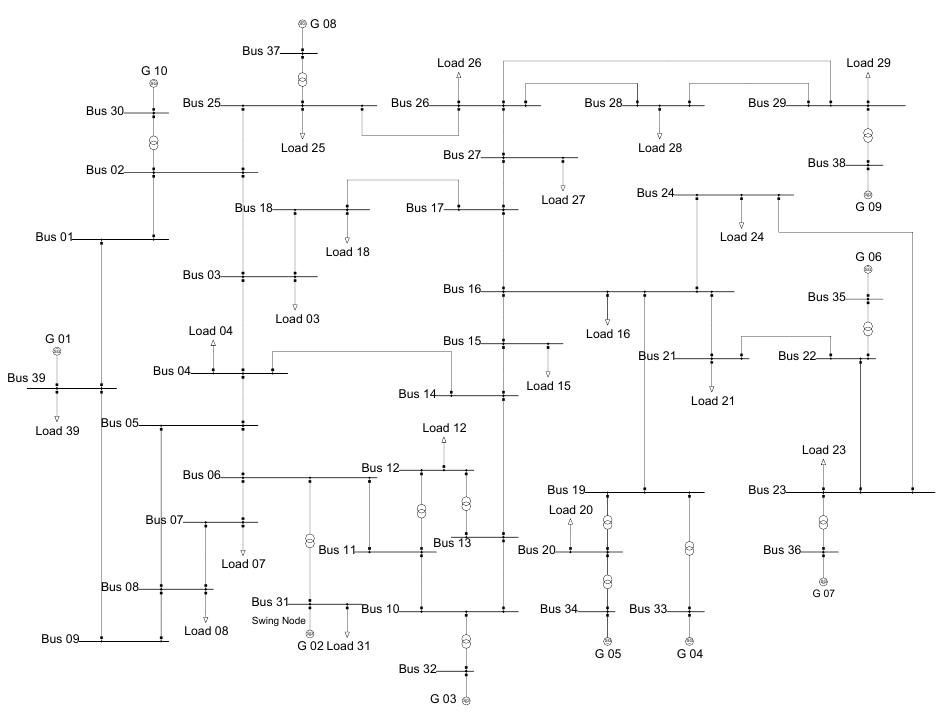
Figure 9. IEEE 39-bus test system